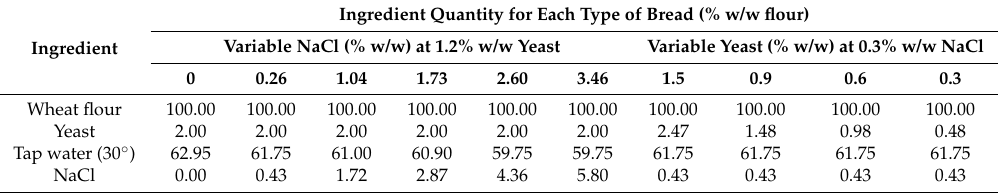
Table 1. Ingredient quantities in the breads containing varying amounts of NaCl at constant yeast (1.2% w/w) and varying amounts of yeast at constant NaCl (0.3% w/w) *. Ingredient Quantity for Each Type of Bread (% w/w flour) Variable NaCl (% w/w) at 1.2% w/w Yeast Variable Yeast (% w/w) at 0.3% w/w Ingredient